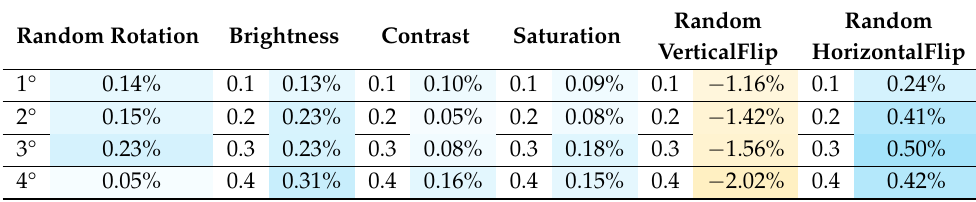
Table A2. Performance of DA methods on Γ train 100 . This heatmap shows the results when we CSD increase the training set samples to 100 per class. The displayed percentage values describe the increase/decrease of mAA in percent. The value is color-coded from blue (increase in accuracy) over white (no effect) to orange (decrease in accuracy). We can see that RandomRotation and RandomVerticalFlip have a negative impact. Saturation with a parameter of 9 and Brightness with a parameter of 1.7 are the two most effective DA methods and